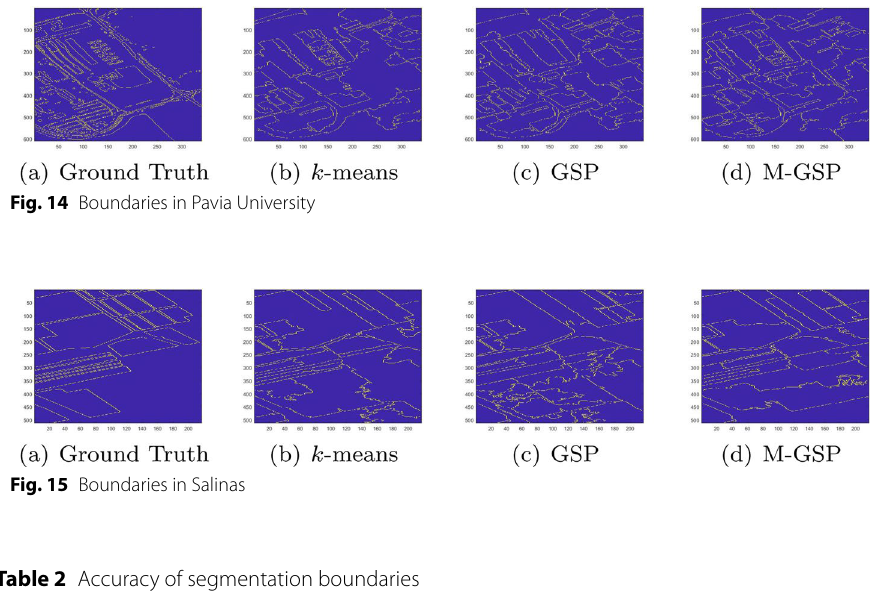
Table 2 Accuracy of segmentation boundaries Data k ‑means GSP M‑GSP